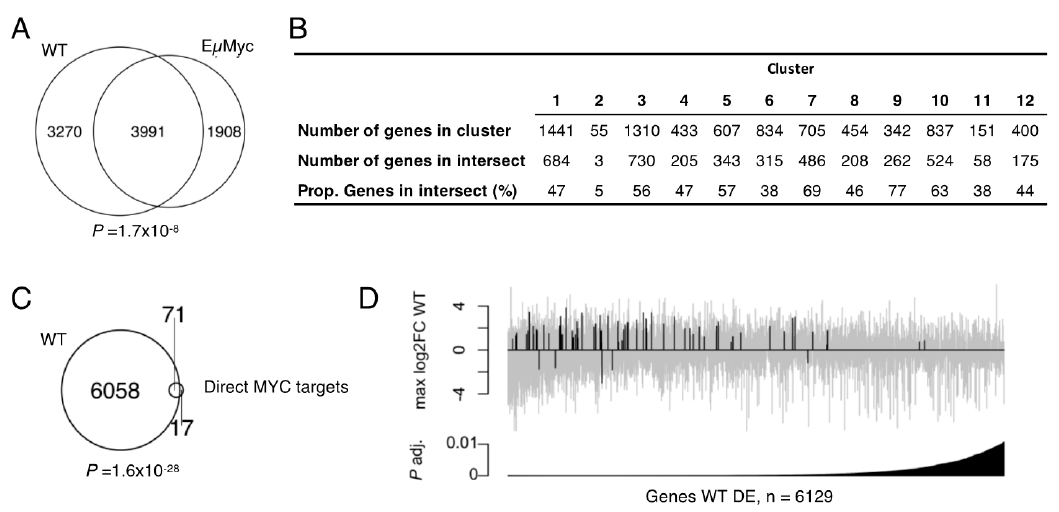
Figure 5. Comparisons with published datasets relevant for MYC-driven lymphogenesis. ( A ) Overlap between differentially regulated genes in WT MYC and significantly changed genes between any of the conditions measured by Sab ò et al. in the E µ -Myc mouse model [18]. p -value from Fisher’s exact test. ( B ) Representation of significantly changed genes in the Sab ò et al. dataset in gene clusters c1–c12. Genes from clusters c3, c7, c9 and c10 were over-represented in the regulated genes from the Sab ò et al. study (Fisher’s exact test, p = 0.02, 6.0 × 10 − 20 , 2.0 × 10 − 20 and 2.0 × 10 − 9 , respectively). ( C ) Overlap between 88 of the 100 most significant direct MYC target genes derived from Muhar et al. [21] that could be converted to the mouse ortholog with a unique gene identifier and genes with significantly altered transcript levels in WT MYC. p -value from Fisher’s exact test. ( D ) A total of 6129 genes that were differentially regulated in WT MYC and that had unique gene identifiers following ortholog conversion between human and mouse ranked by adjusted p -value. Each grey bar represents one gene with the 71 genes that were also present in the data from Muhar et al., marked in black. The set of 71 genes was significantly enriched in the set of most significantly regulated genes in WT MYC (Fisher’s exact test, p -value = 0.0012).